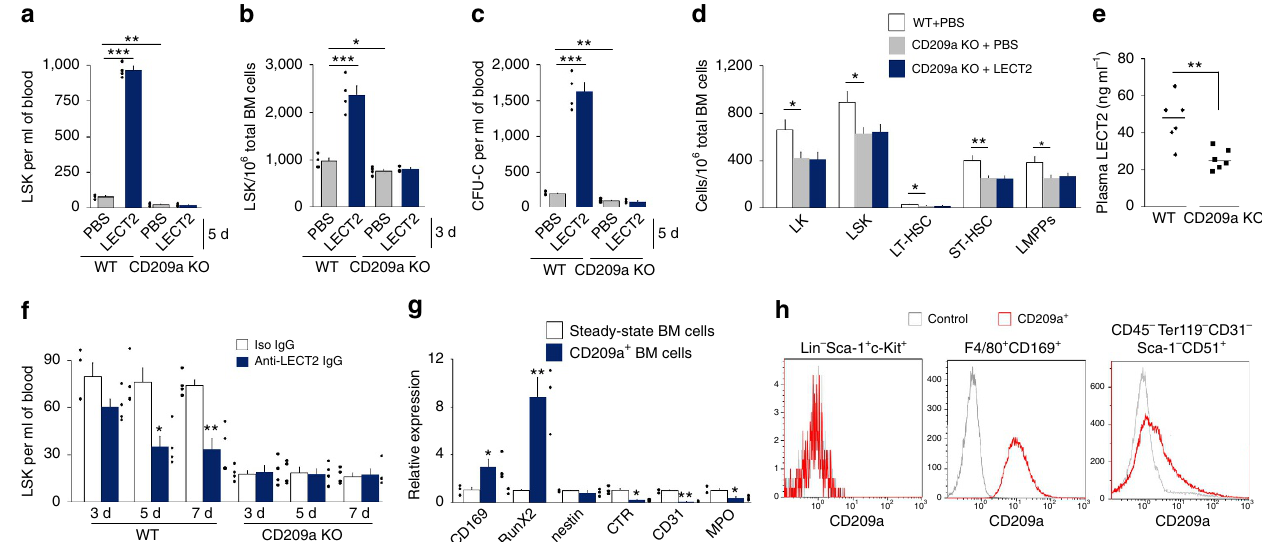
Figure 3 | CD209a in BM niche cells mediates the effect of LECT2 on HSC mobilization and expansion. ( a , b ) The number of LSK cells in the blood ( a ) and BM ( b ) of WT and CD209a KO mice after PBS or LECT2 treatment. ( c ) The number of CFU-Cs in the blood of WT and CD209a KO mice. ( d ) The number of LK cells, LSK cells, LT-HSCs, ST-HSCs and LMPPs in the BM of LECT2-treated CD209a KO mice; n ¼ 4. ( e ) LECT2 protein levels in WT and CD209a KO mice; n ¼ 6. ( f ) LSK cell number in WTand CD209a KO mice after isoIgG or anti-LECT2 IgG treatment. ( g ) The mRNA levels of BM cell markers in CD209a þ BM cells relative to the level in steady-state BM cells. CD169, a marker of macrophages; RunX2, a marker of osteolineage cells; nestin, a marker of mesenchymal stem or stromal cells; calcitonin receptor (CTR), a marker of osteoclasts; CD31, a marker of endothelial cells; myeloperoxidase (MPO), a marker of neutrophils. ( h ) A representative histogram of the percentage of CD209a-positive cells within LSK cells, macrophages and osteolineage cells in the steady-state condition; n ¼ 4. The small black dots in histograms are data points. The data represent means ± s.e.m. The data are representative of two independent experiments. * P o 0.05, ** P o 0.01, *** P o 0.001 using one-way ANOVA.